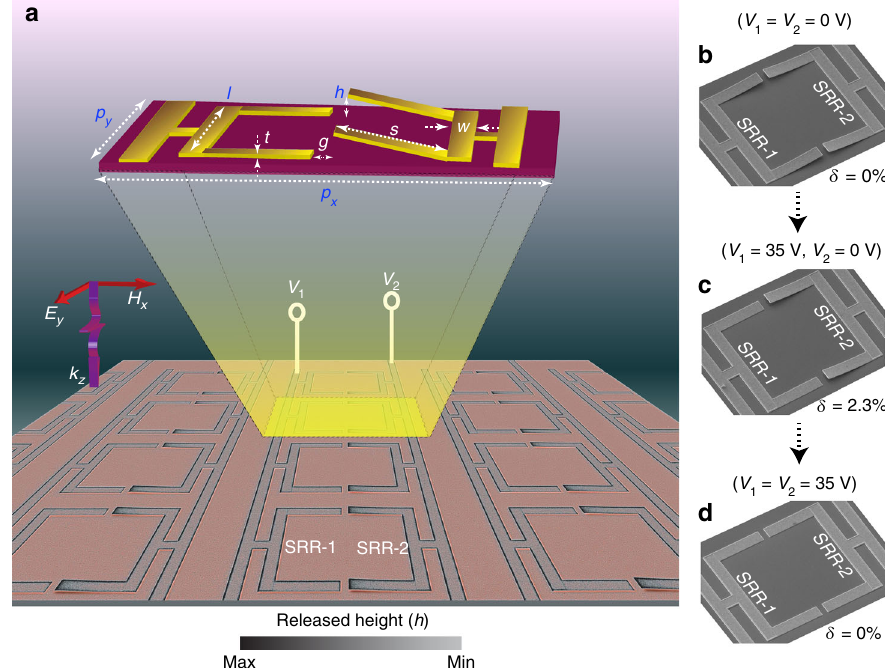
Fig. 1 Fabricated sample images and the sequential operation of the device. a Coloured scanning electron microscope (SEM) image of the MEMS Fano- metasurface. The unit cell comprises of two SRRs separated by a gap g , where SRR cantilever arms of length s are released at a height h . The unit cell dimensions are depicted in the inset, where p x : 110 μ m; p y : 75 μ m; l : 60 μ m; s : 25 μ m; w : 6 μ m; g : 4 μ m; and t : 900 nm. V 1 and V 2 are the input voltage ports to achieve the independent actuation of SRR-1 and SRR-2, respectively. b – d SEM images of the unit cell showing the sequential actuation of SRRs with voltage V 1 and V 2 applied across the two SRRs, where the sequence from ( b ) to ( c ) represents the increasing asymmetry ( δ ) and ( c ) to ( d ) represents